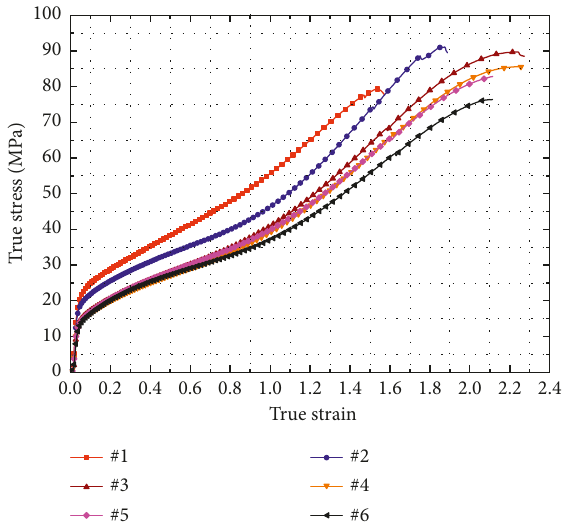
Figure 4: True stress-strain curves of specimens #1–#6.